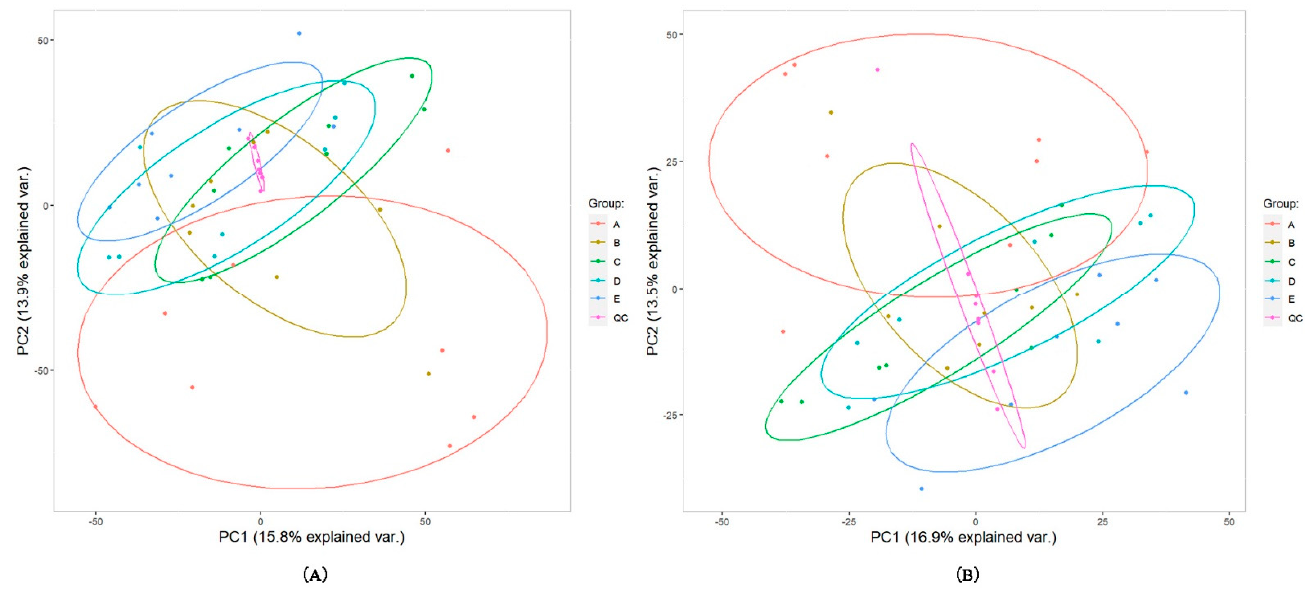
Figure 2. The PCA analysis. A–E (in figure): every 7 days from the day of delivery until 28 days after delivery (5 time points). QC: quality control (all samples mixed). The figure ( A ) and ( B ) was positive and negative ion mode, respectively.